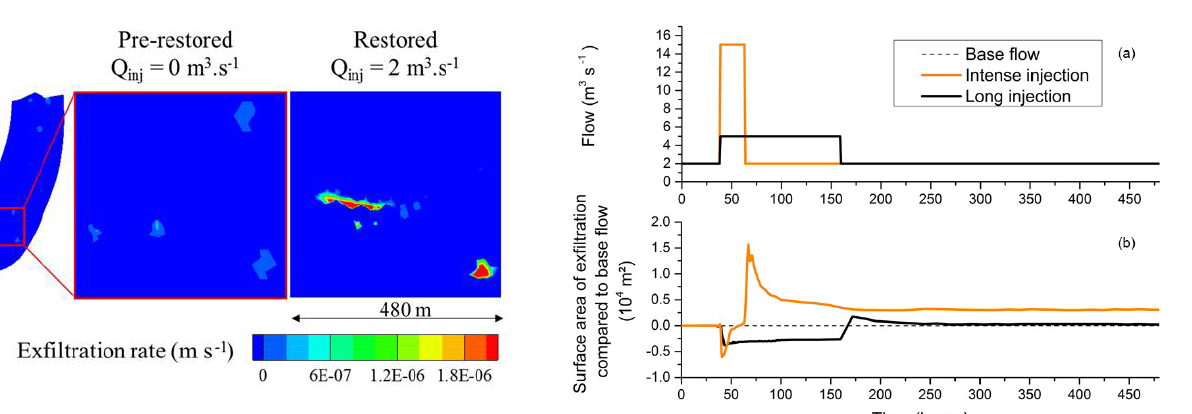
Figure 11. Patterns of exfiltration for the pre-restored and the restored situations. The focus is on the most active zone of Rohrschollen Island regarding surface–subsurface interactions.